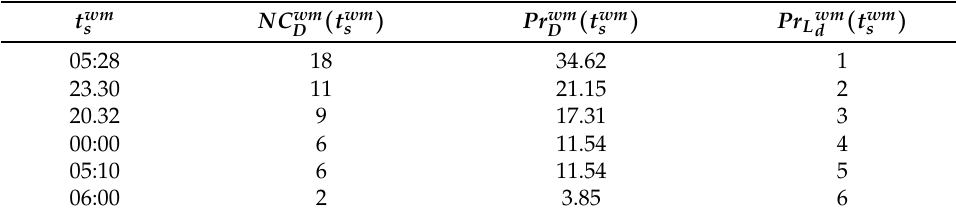
Table 9. Priority level values for t wm s